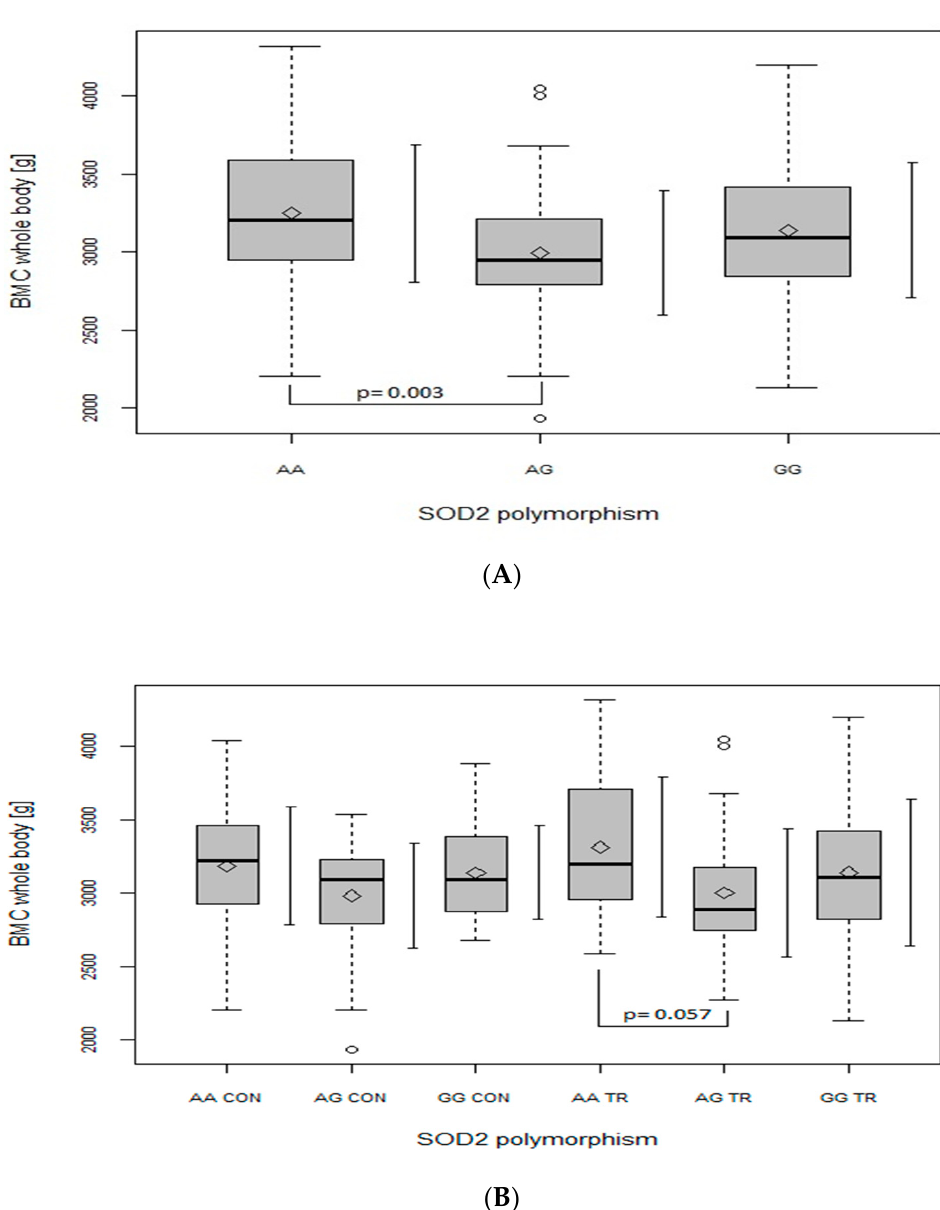
Figure 4. The effect of SOD2 polymorphism on bone mineral content (BMC) (g) of the whole body. ( A ): in the whole group; main effects: SOD2 ( p = 0.004; F = 5.71). ( B ): in control (CON) and trained (TR) group; main effects: SOD2 ( p = 0.004; F = 5.65). Key: ◊ —mean; ○ —outliers value; boxplots—median Q1–Q4 and mean ± SD.